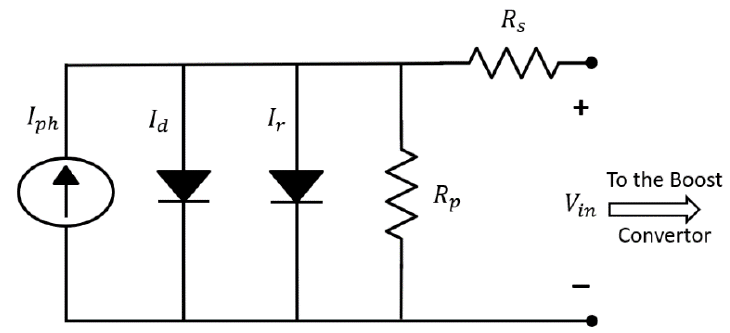
Figure 3. Equivalent circuit for practical photovoltaic (PV) solar cell.